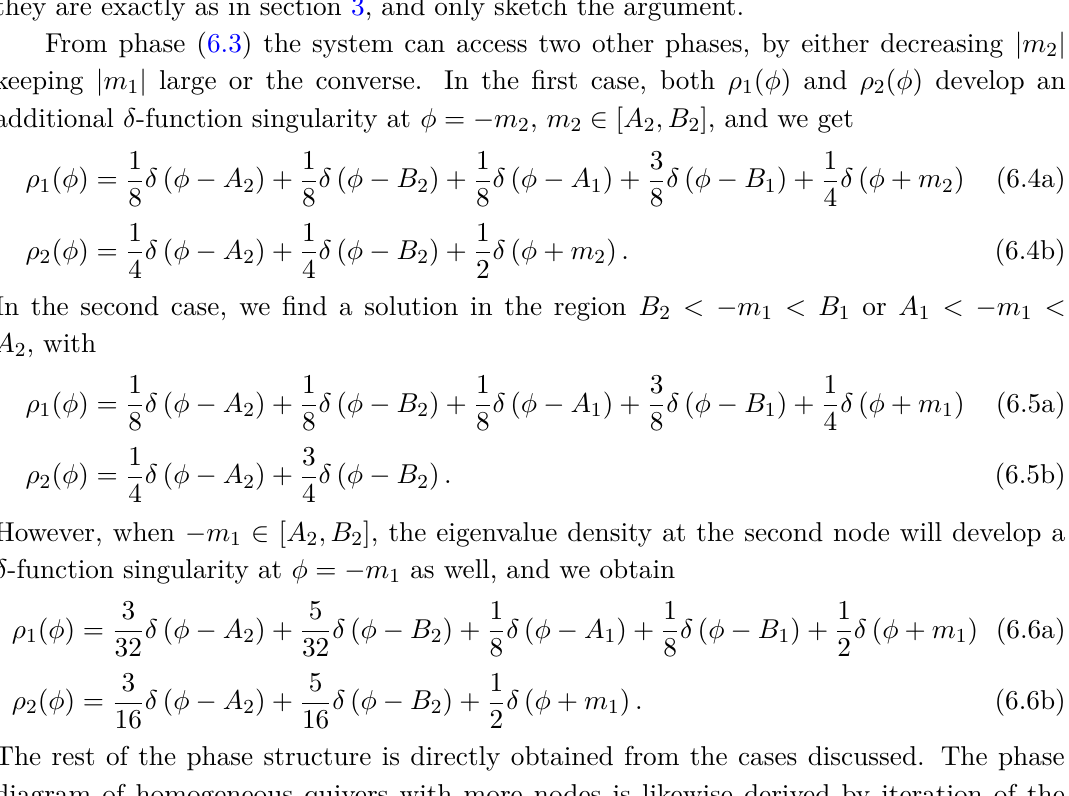
Figure 16 . Circular U( N ) × U( N )